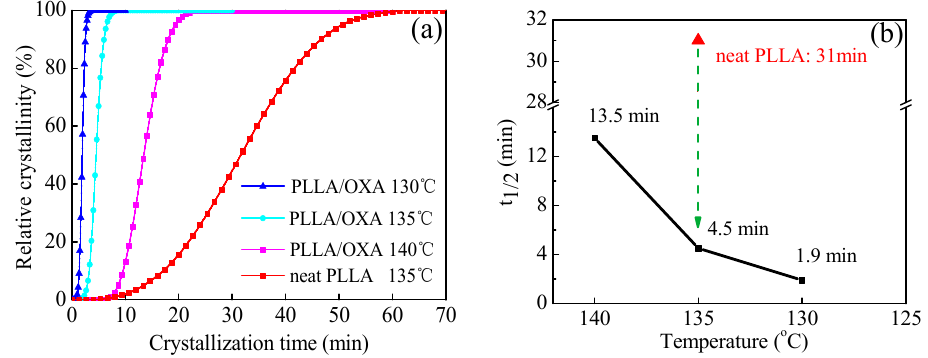
Figure 3. ( a ) The relative crystallinity ( X t ) of PLLA and PLLA/OXA as a function of crystallization time ( t ), and ( b ) the corresponding half-life crystallization time ( t 1/2 ) obtained at X t = 50%.